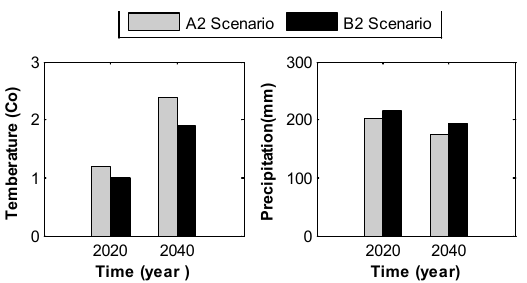
Fig. 4 The temperature anomaly and precipitation for A2and B2 scenarios.